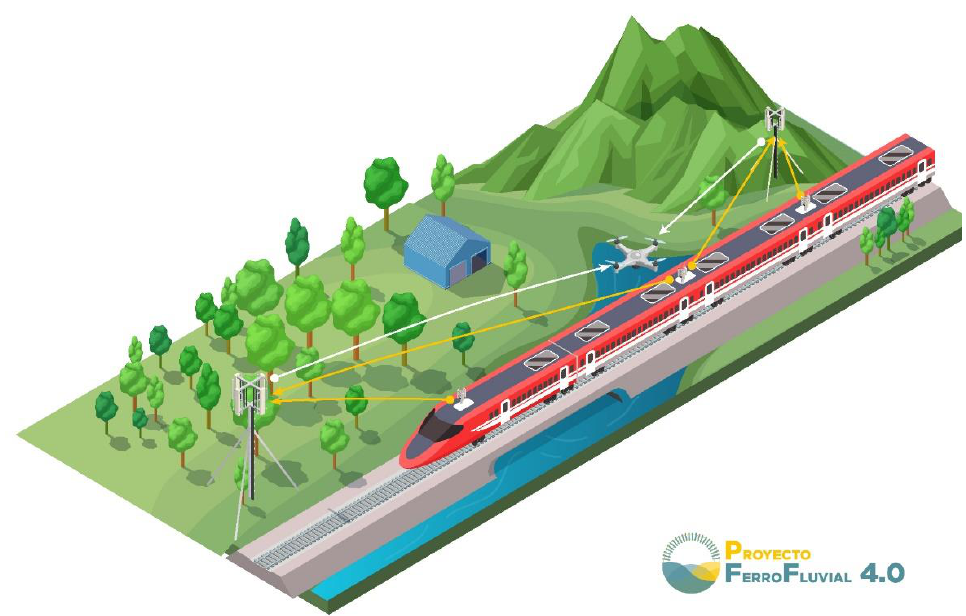
Figure 8. Proposed travel connectivity architecture in [78].